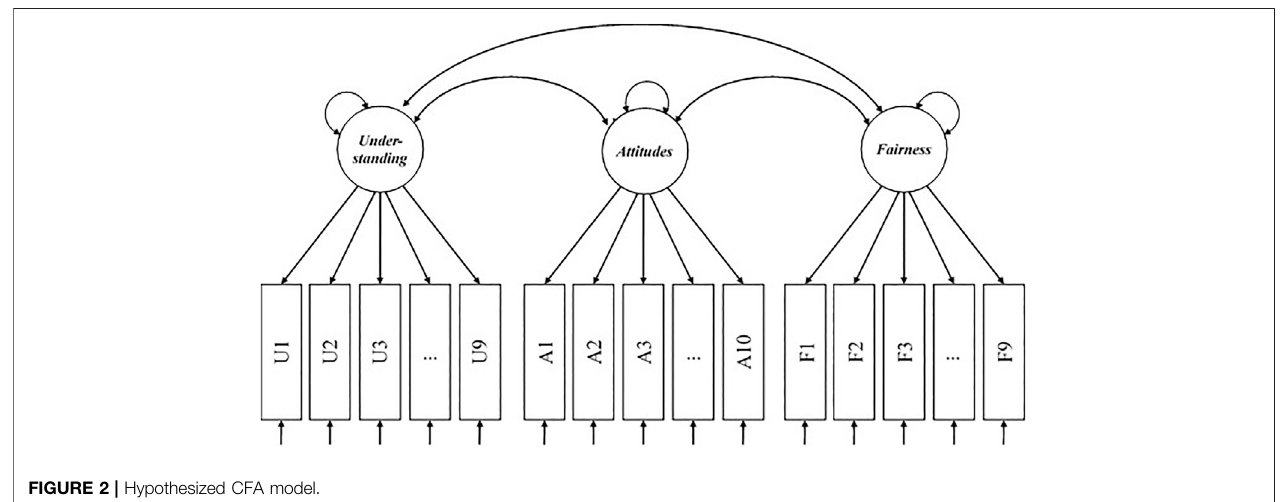
FIGURE 2 | Hypothesized CFA model.